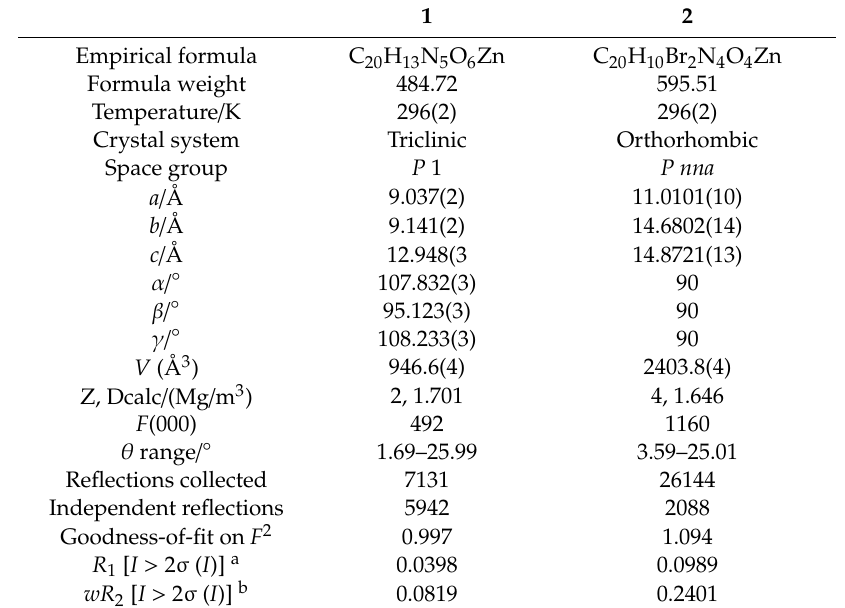
Table 1. Crystallographic data and structure refinement details for coordination polymers (CPs) 1 and 2